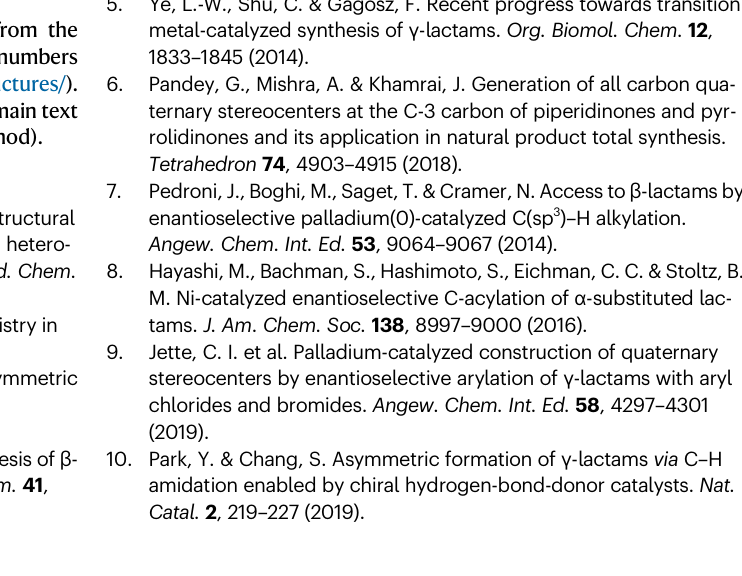
scavenger. The yields were reported as corrected GC yield with dodecane as an internal standard. c Plausible